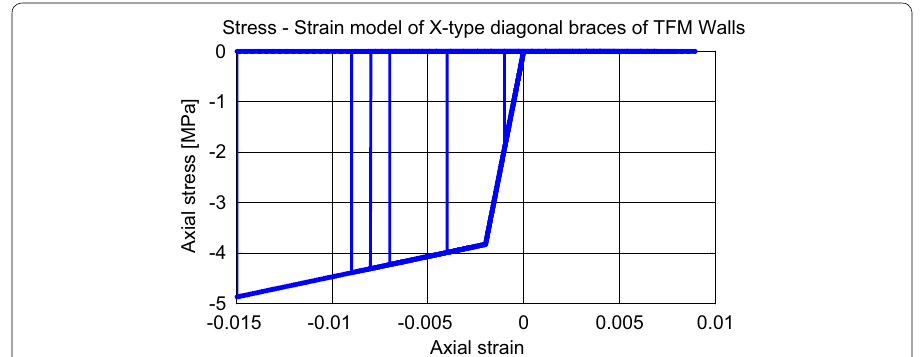
Fig. 11 Stress–strain material model of the non-linear truss elements representing X-type timber diagonal